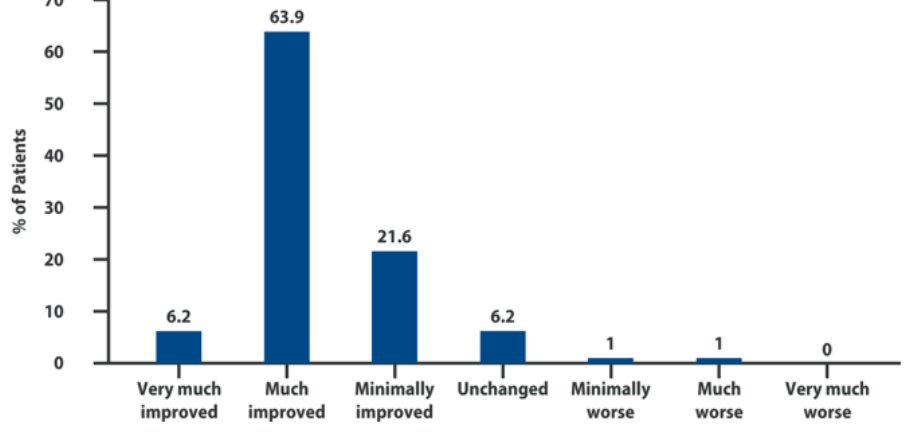
by the investigators as not related to the treatment [73].